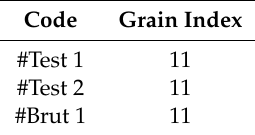
Figure 19. #Brut 1. Grain index (ASTM E112-13) G = 11.